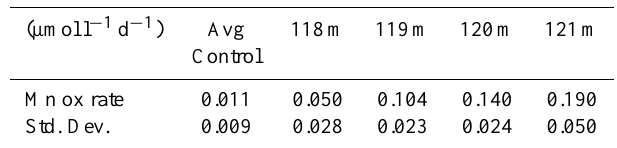
Table 3. Mn oxidation